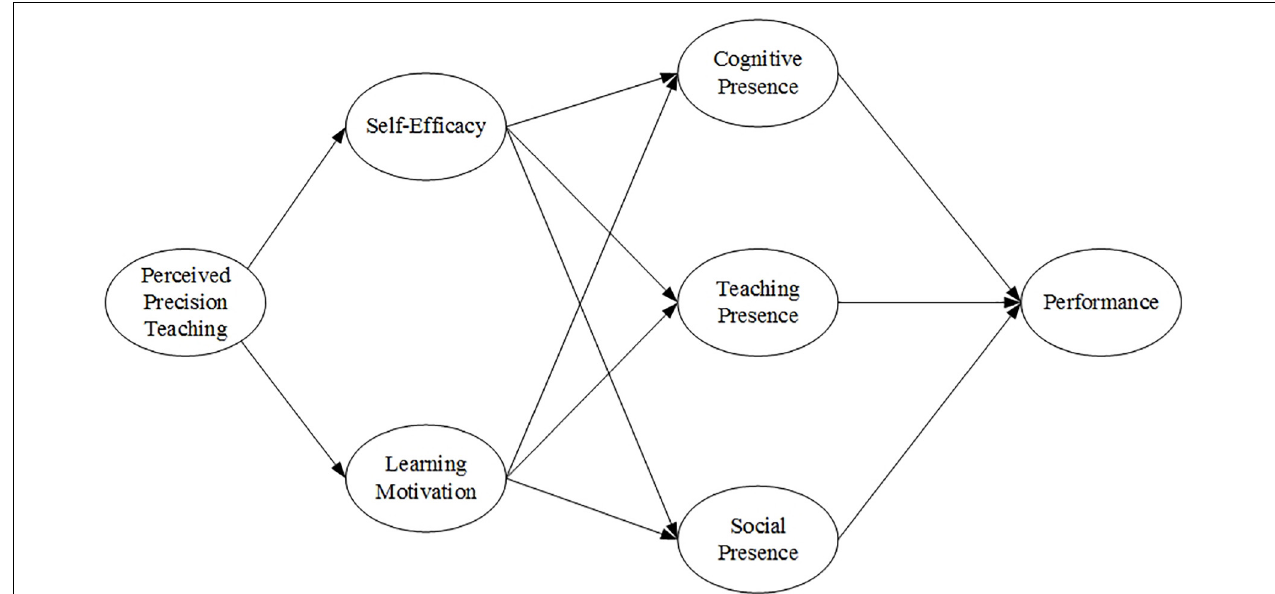
FIGURE 2 | Research